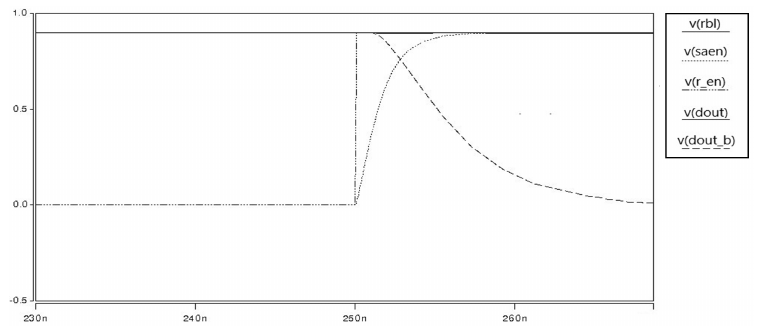
Figure 27. Waveform of Reading 1 operations in